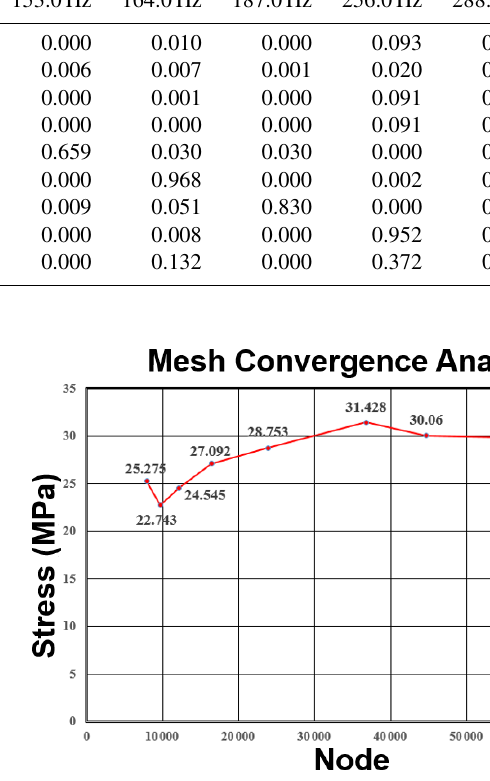
Figure 31. Rear wheel axle fastener convergence